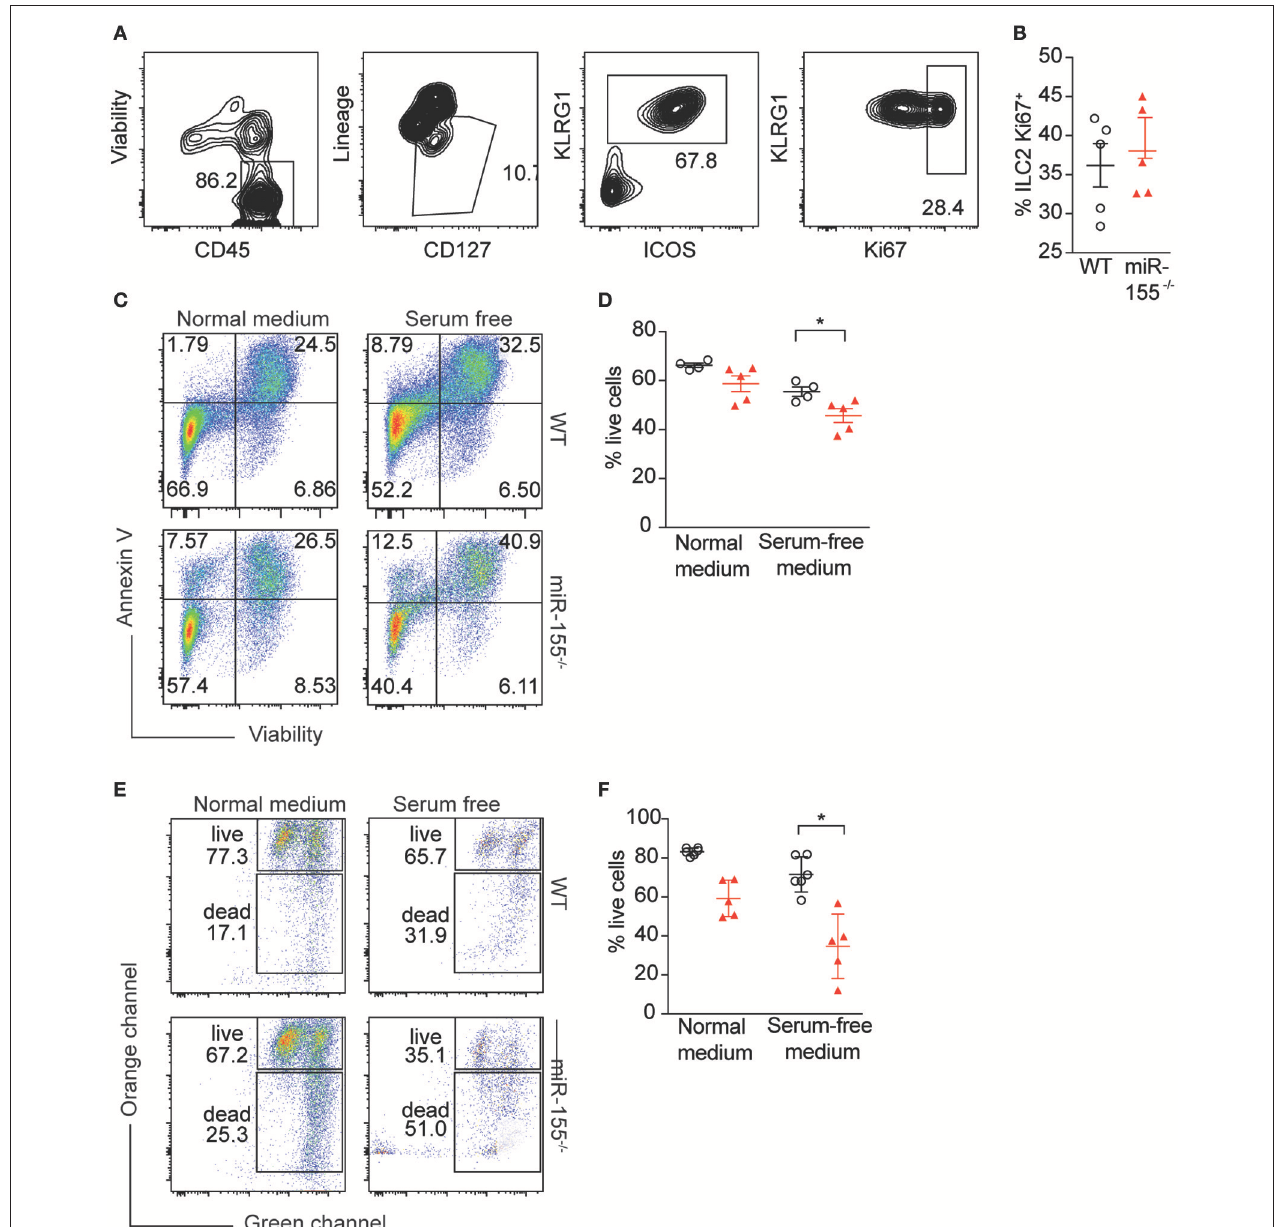
FIGURE 6 | miR-155 protects ILC2 from undergoing apoptosis. LNs were excised from IL-33-treated WT and miR155 − / − mice and CD3 + , B220 + , CD11b + , and CD11c + cells depleted using dynabeads. The remaining cells were cultured in 10ng/ml IL-7 and IL-33 for 1 week and ILC2 proliferation assessed using Ki67 staining. (A) Representative flow cytometry for Ki67 staining. (B) Proportion of Ki67-positive ILC2 from LN analyzed ex vivo from WT and miR155 − / − mice treated in vivo with IL-33 for 3 days. (C,D) Annexin V and viability staining of ILC2. WT or miR155 − / − ILC2 were isolated from MLN of IL-2/anti-IL-2/IL-25- or IL-33- treated animals and then expanded in vitro in the presence of IL-33 for 5 days. Following culture, cells were either kept in growth medium or serum-starved (in RPMI only) for 6h. (C) Representative FACS plots. (D) Enumeration of live vs. apoptotic cells. (E,F) Mitochondrial depolarisation was assessed using JC-1 staining (culture as for C,D ). (E) Representative FACS plots. (F) Enumeration of live vs. apoptotic cells. Data are representative of two (B–D) or three (E,F) independent experiments. Student’s t- test, * p ≤